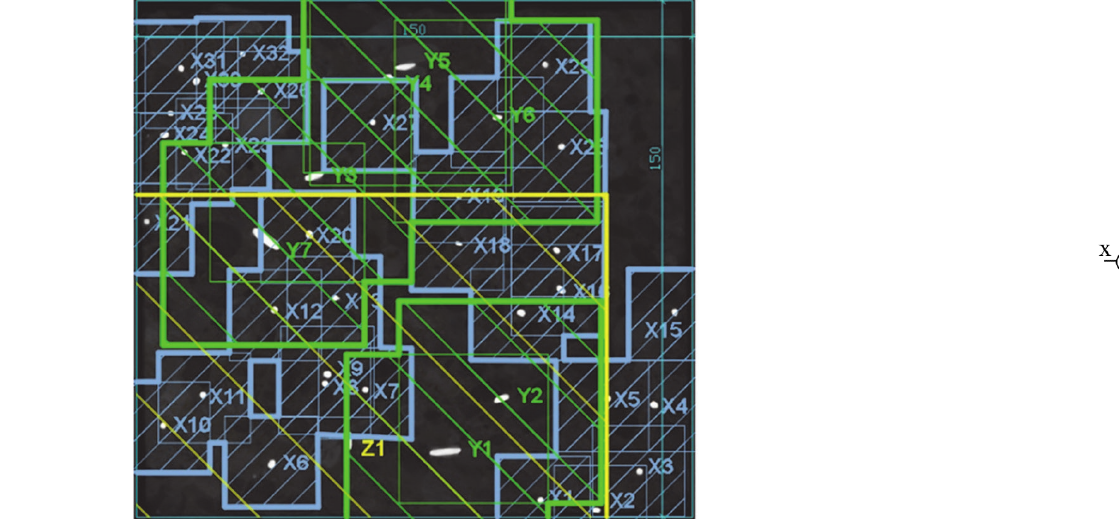
Figure 5. The fiber assigned squares along the axis “x” in blue, the “y” direction green and “z” yellow